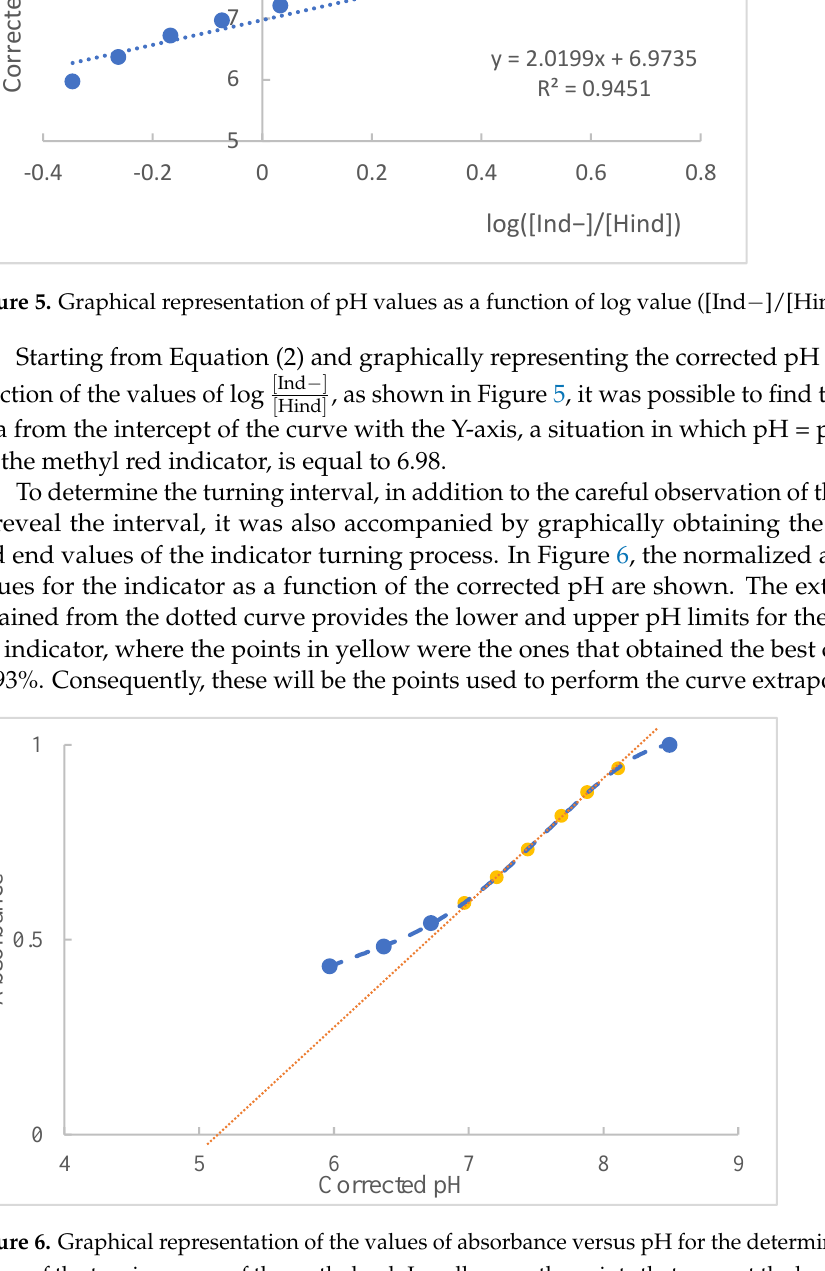
Figure 6. Graphical representation of the values of absorbance versus pH for the determination of the values of the turning range of the methyl red. In yellow are the points that present the best correlation and were used to perform the extrapolation of the curve.